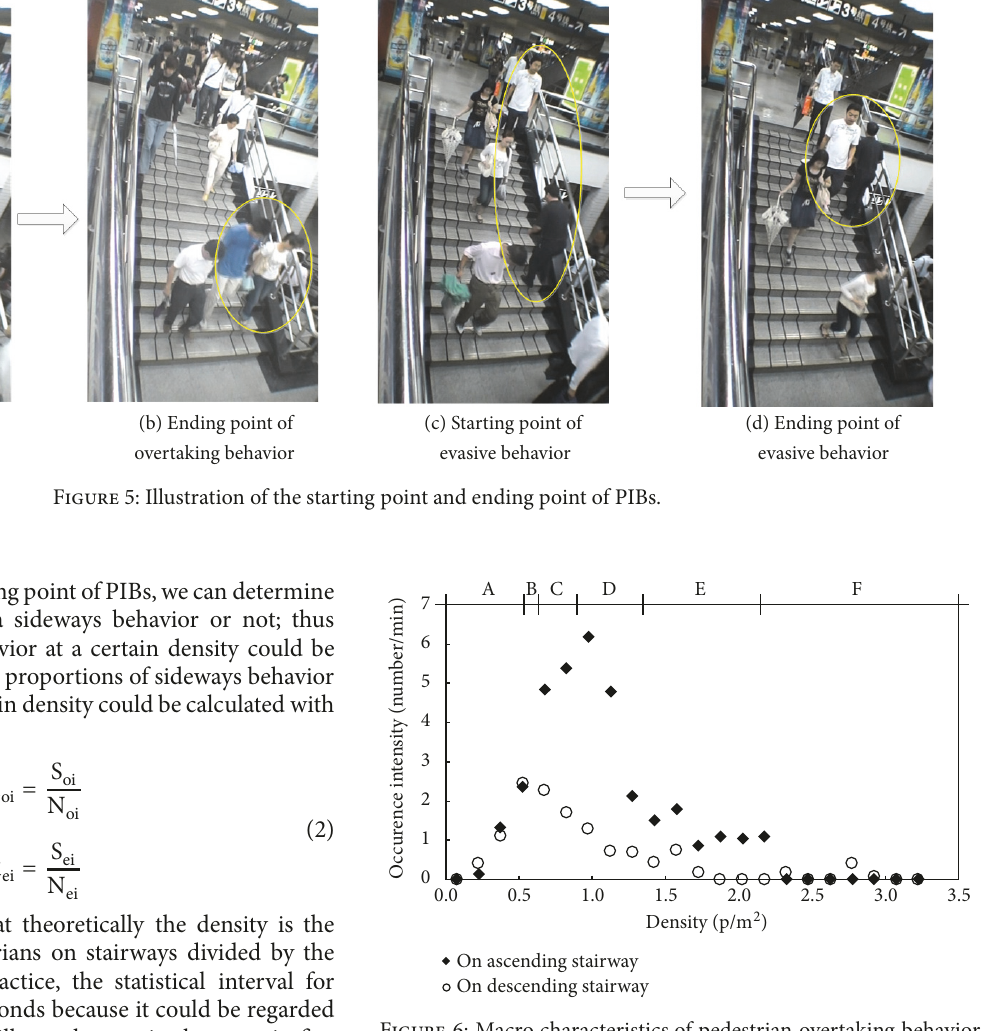
Figure 6: Macro characteristics of pedestrian overtaking behavior on